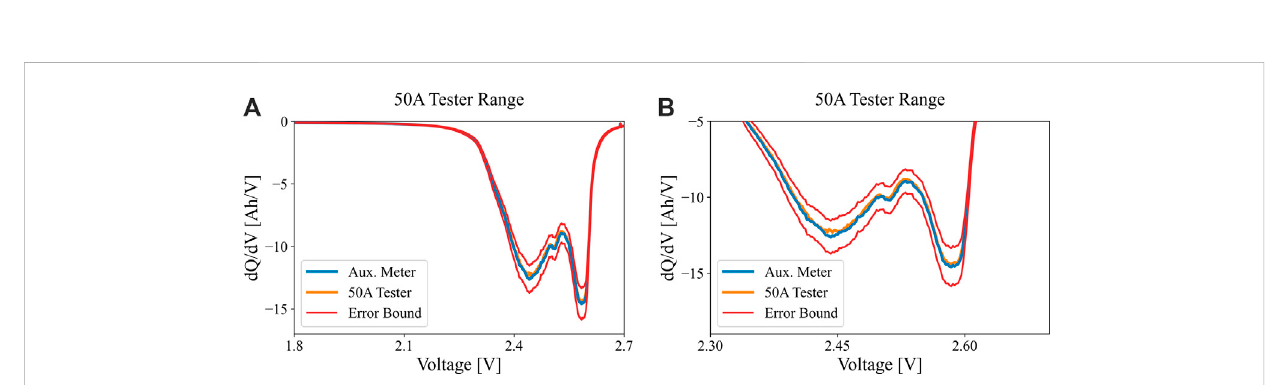
FIGURE 6 (A) dQ/dV signatures of an LMO/LTO cell at C/20 discharge (0.145 A) using the 50 A Maccor range (orange) versus the Keysight multimeter (blue). Maximum possible ± variance is imposed, resulting in the red set of pro fi les. For the sake of clarity panel (B) enlarges the range of interest